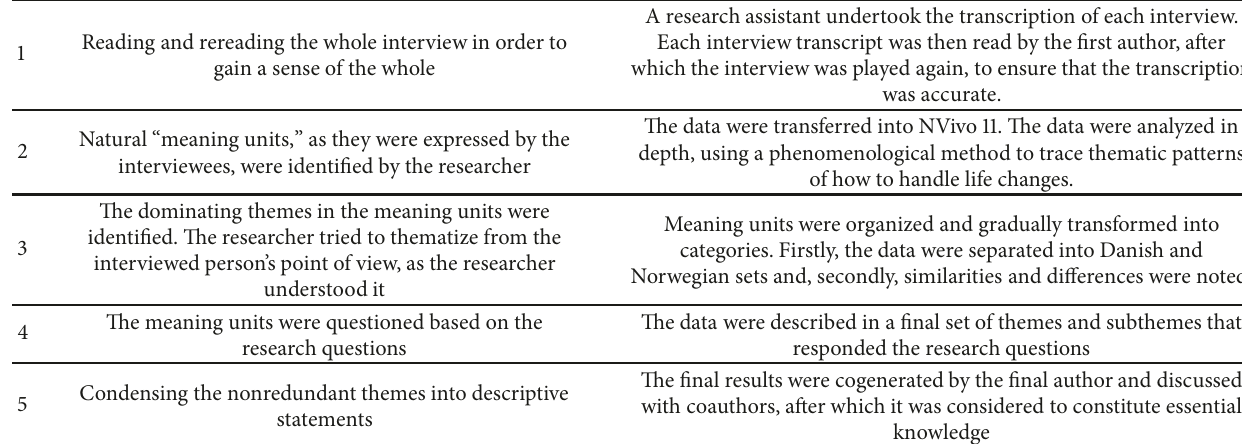
Table 2: Five steps in the analytical process inspired by Giorgi